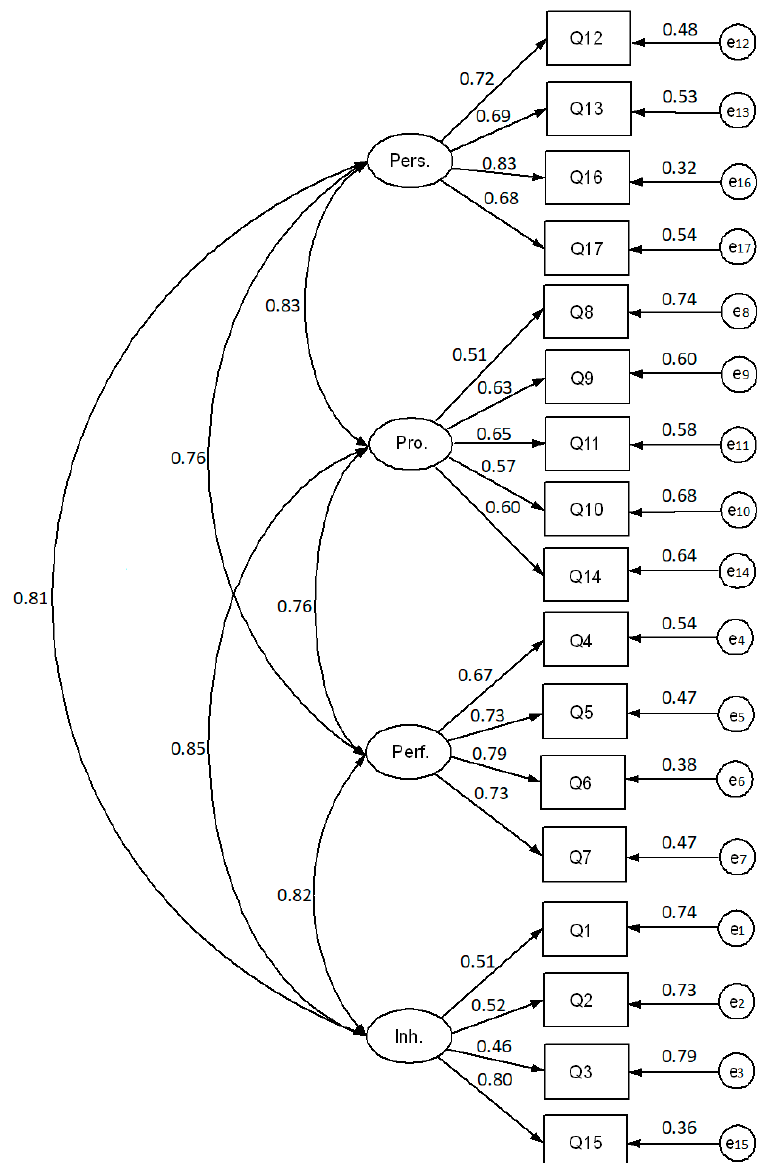
Figure 2. Confirmatory factor analysis estimates of the 17-item questionnaire in Polish to measure the career satisfaction of physicians. The dimensions of career satisfaction are personal (pers.), professional